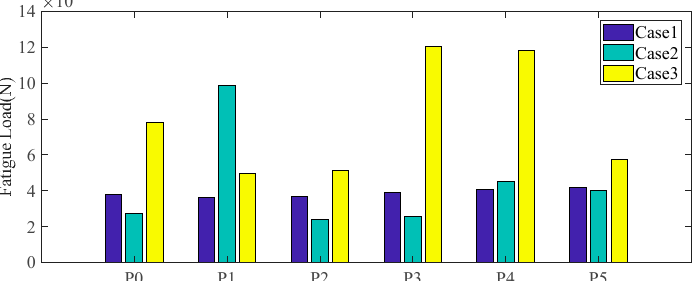
Figure 17. Fatigue loads of the mooring line in different load cases.